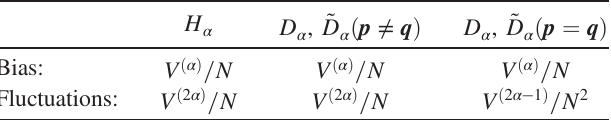
ˆ X TABLE I. Scaling of the bias j E ½ (cid:3) − X j and the fluctuations large sequence sizes N and depend on the vocabulary of order α , V ð α Þ as in Eqs. (13) and (14). Results are shown for X ¼ H α [order α entropy, Eq. (4)], D α [generalized divergence], and ~ D α [normalized divergence, Eq. (5)] (see Appendix B for